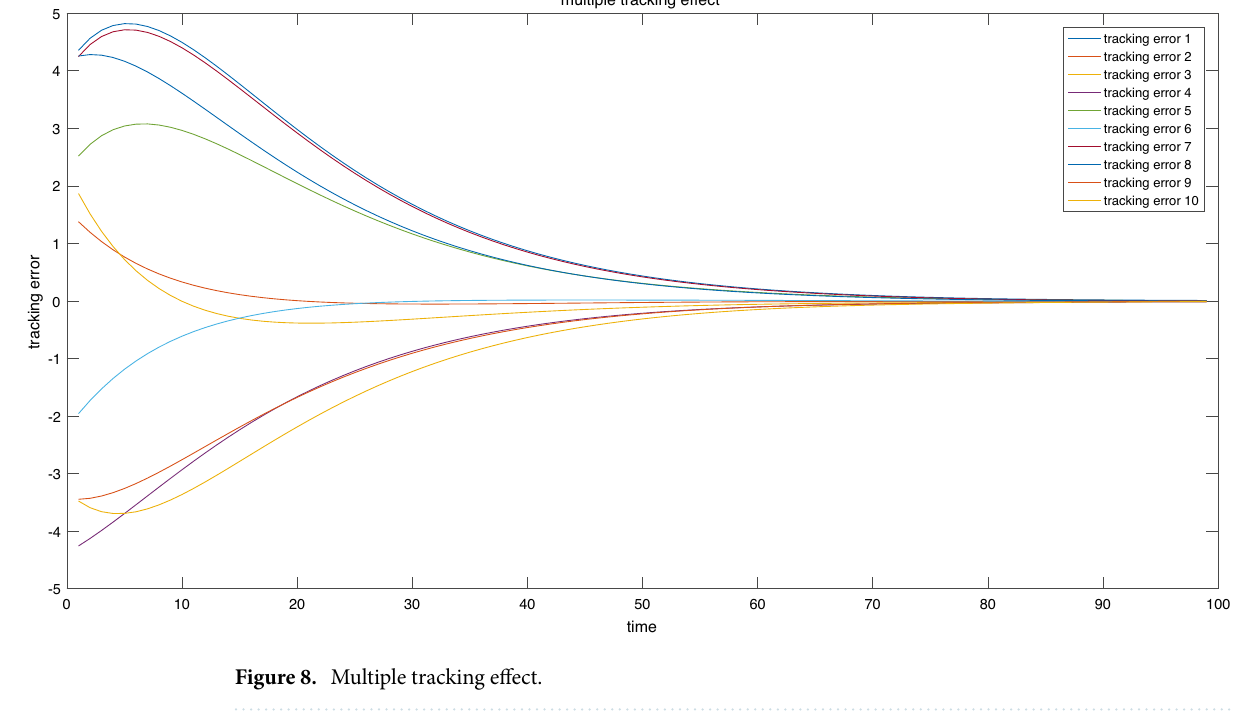
Figure 8. Multiple tracking